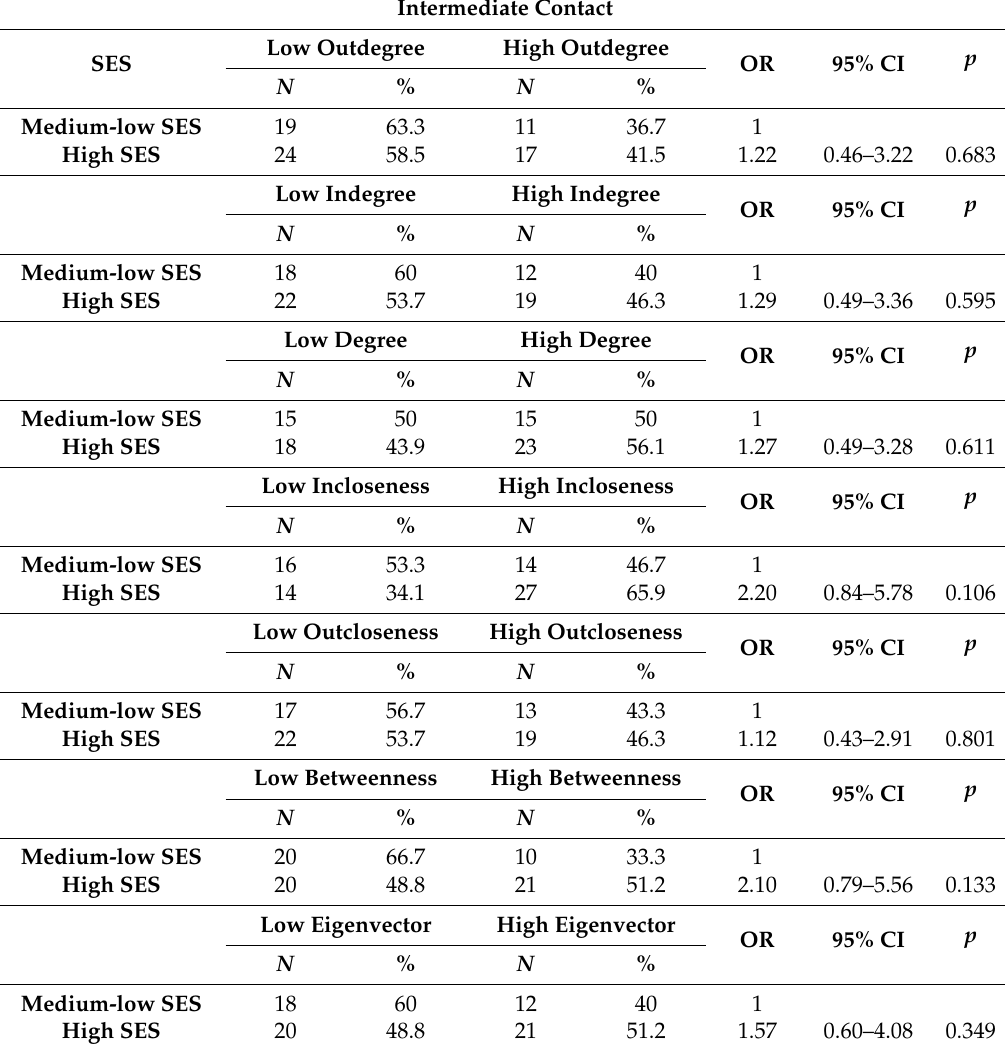
Table 5. Estimation of probability of the relationship between SES in the overweight adolescent and network parameters, at the intermediate contact intensity